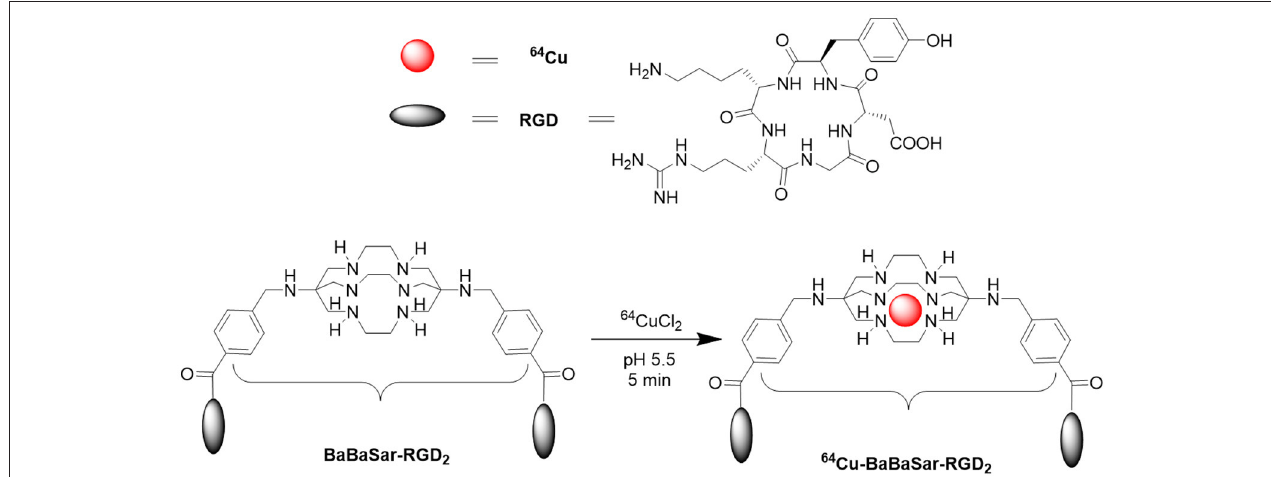
FIGURE 1 | Structure of RGD and the synthetic scheme for 64 Cu-BaBaSar-RGD 2 .